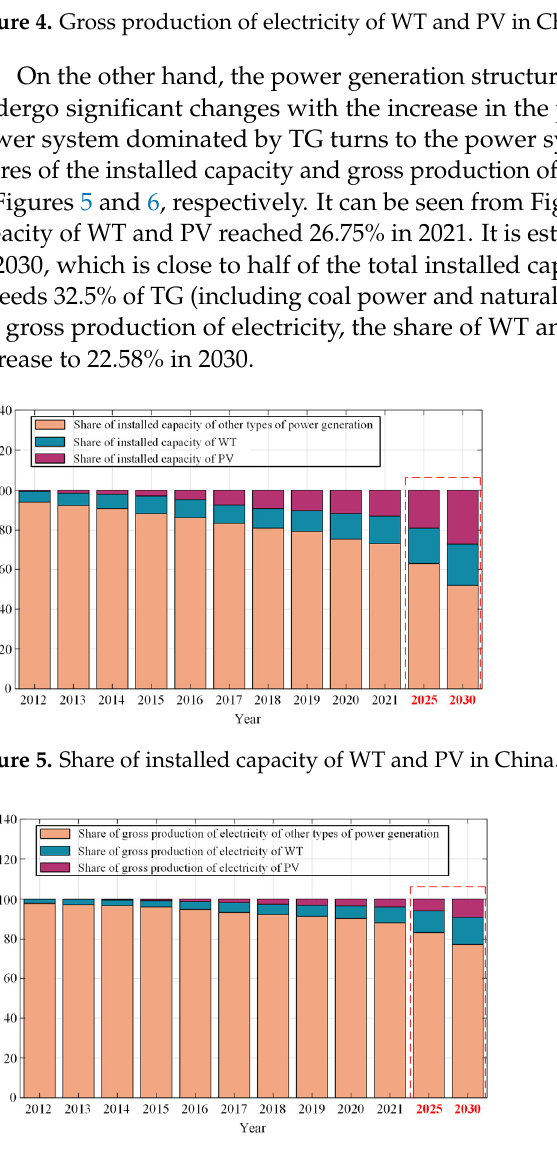
Figure 4. Gross production of electricity of WT and PV in China.